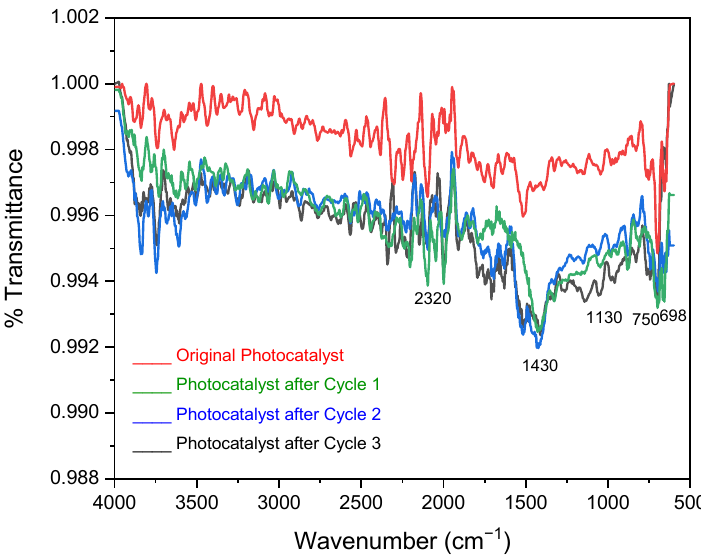
Figure 11. FTIR spectra of catalyst after repetitive degradation cycles.